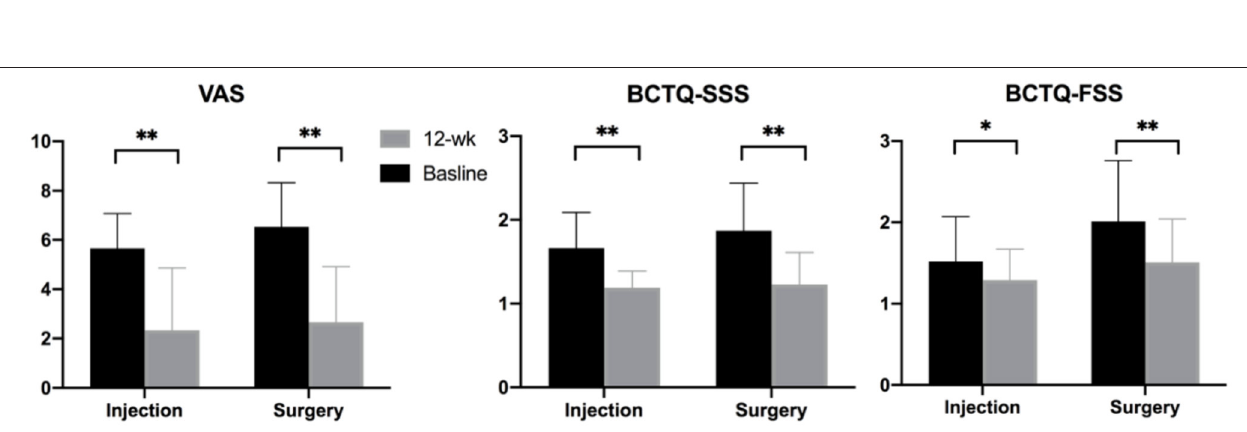
FIGURE 3 | Median nerve cross-sectional area (CSA) and median nerve mobility-related parameters obtained at baseline and 12-week follow-up. Note: * p < 0.05.